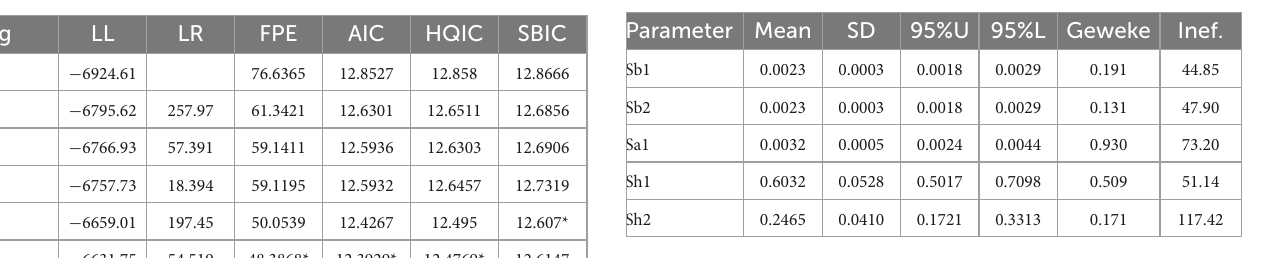
TABLE 5 Optimal lag order. TABLE 6 Parameter estimation